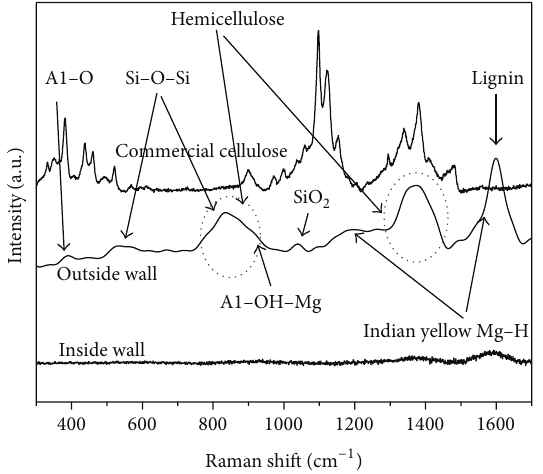
Figure 4: Raman spectra of the inner and outer GAKVB